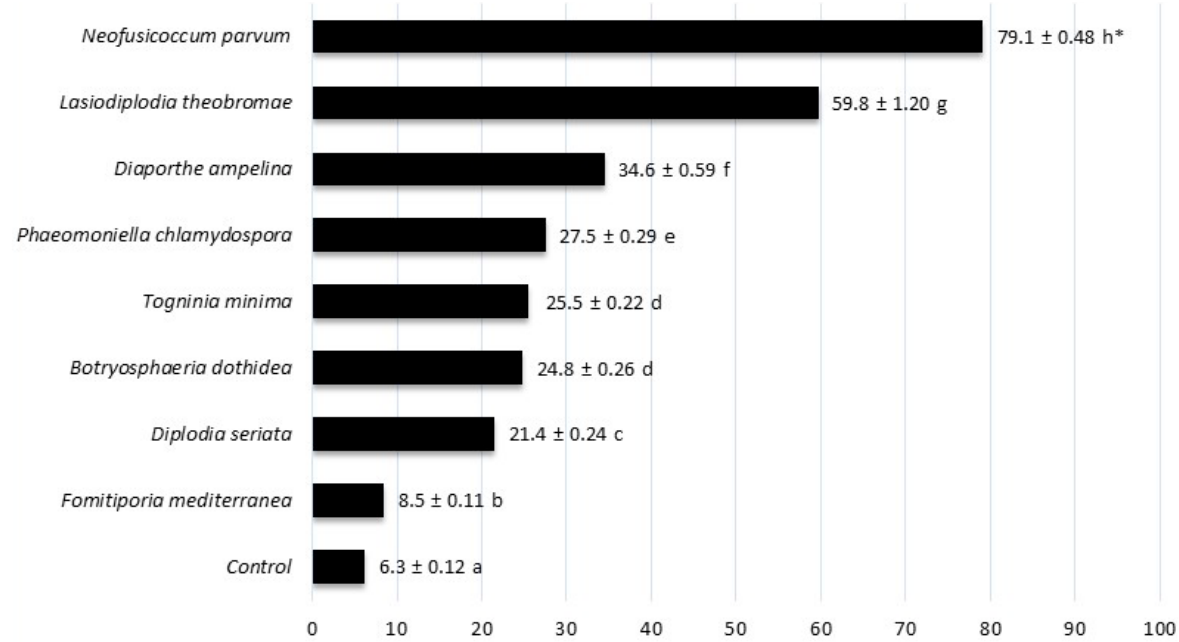
Figure 2. Mean lesion lengths (mm) of the species in pathogenicity test. * Mean values within a bar are significantly different at the 0.05 level based on LSD test. Mean values (from four isolates in each species) correspond to the extent of wood discoloration measured in pathogenicity tests. LSD (5%):